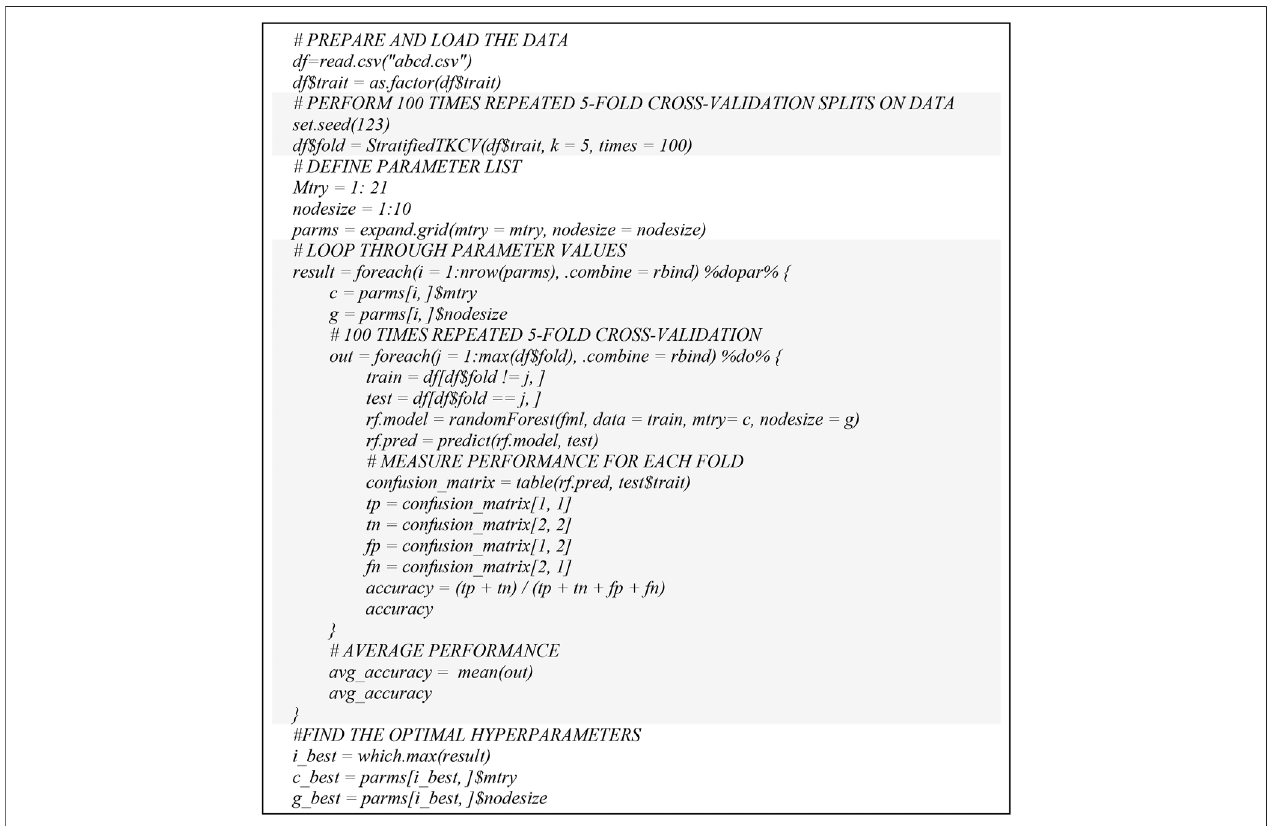
FIGURE 3 | Pseudo code for parallel RF hyperparameter